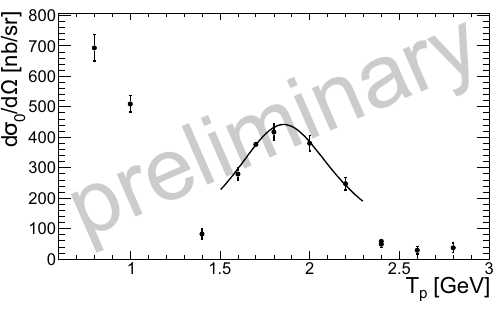
Figure 2. Energy dependence of the di ff erential cross section d σ/ d Ω at zero angle for the reaction pp → { pp } s π 0 . The curve is a Breit-Wigner fit to the data with the mass m = 2646 ± 5 MeV and the width Γ = 132 ± 14 MeV.